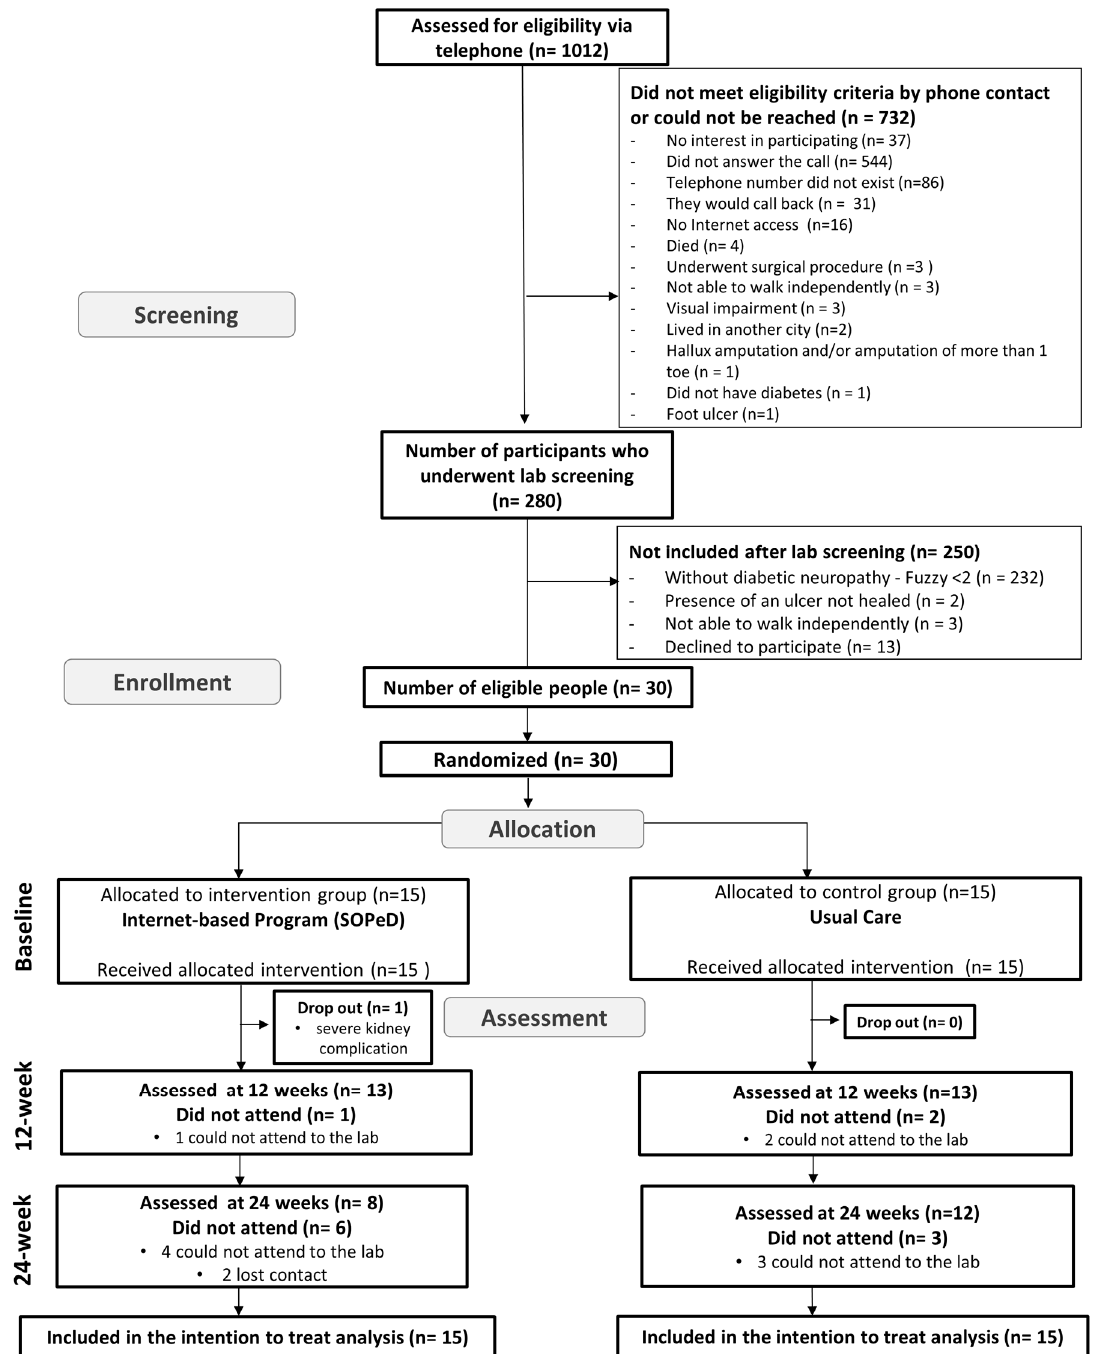
Figure 1. Flowchart of recruitment, assessment, and follow-up process of the proof-of-concept study.